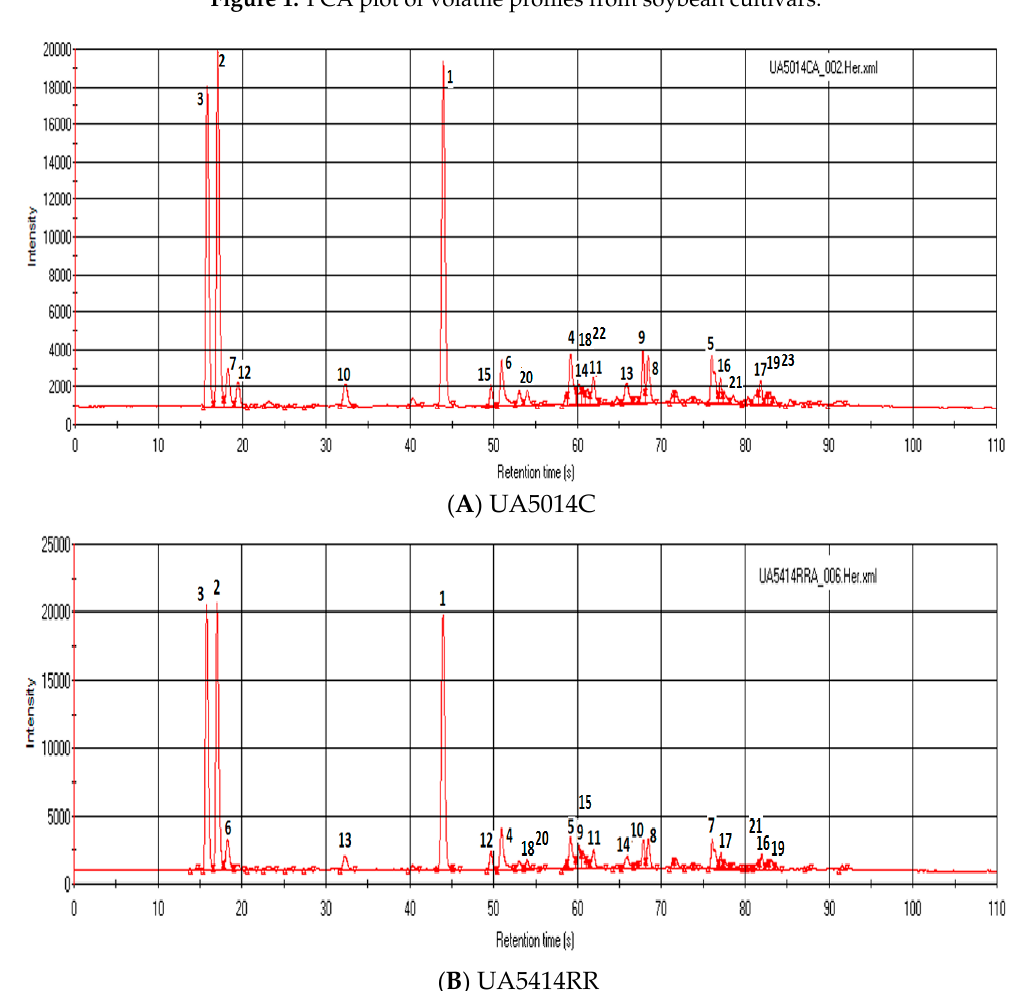
Figure 1. PCA plot of volatile profiles from soybean cultivars.